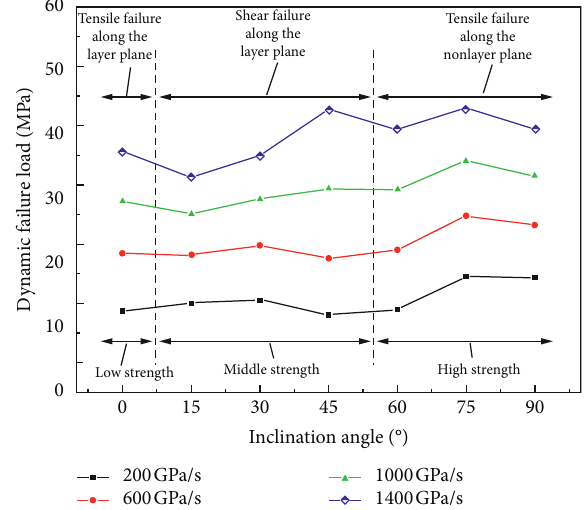
Figure 11: The relationship between the dynamic failure load and the inclination angle for four loading